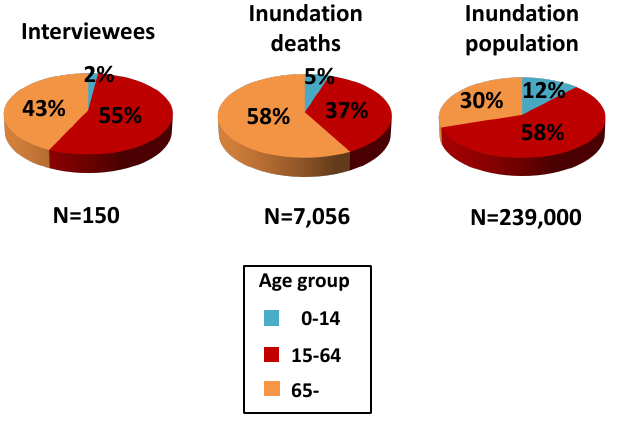
Fig. 3. Demographics of the three age groups: 0–14, 15–64, and 65 and older. The age distribution of the interviewees in this study, the death tolls in the six studied cities and the number of people in the six cities whose addresses were in the 2011 tsunami inundation areas are shown. The data used in the middle and right plots are after Tani (2012). “N” shows the number of samples.